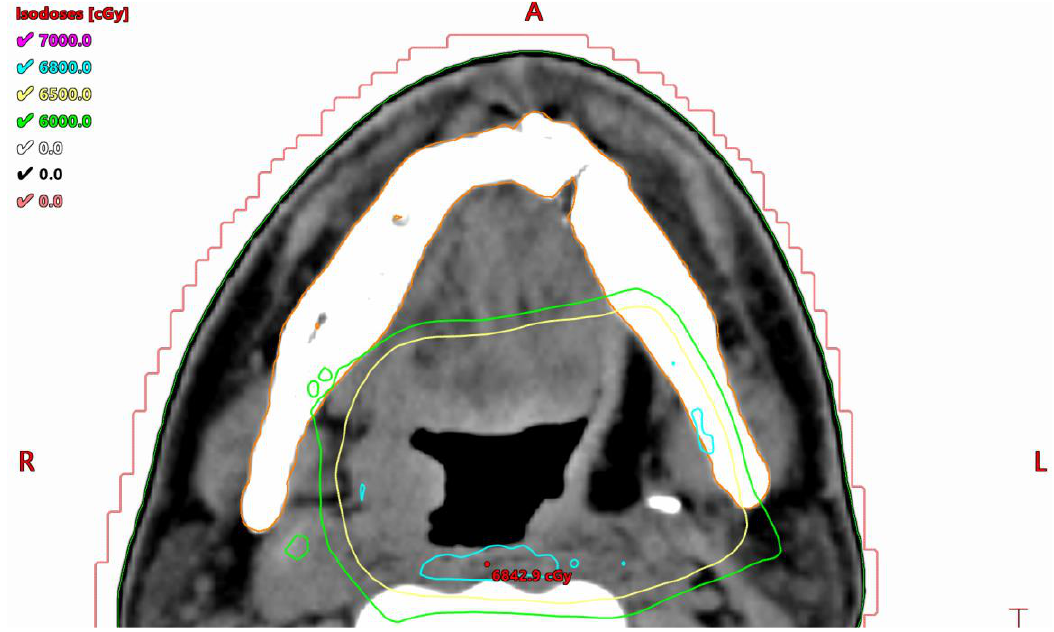
Figure 1. Absorbed dose distribution in